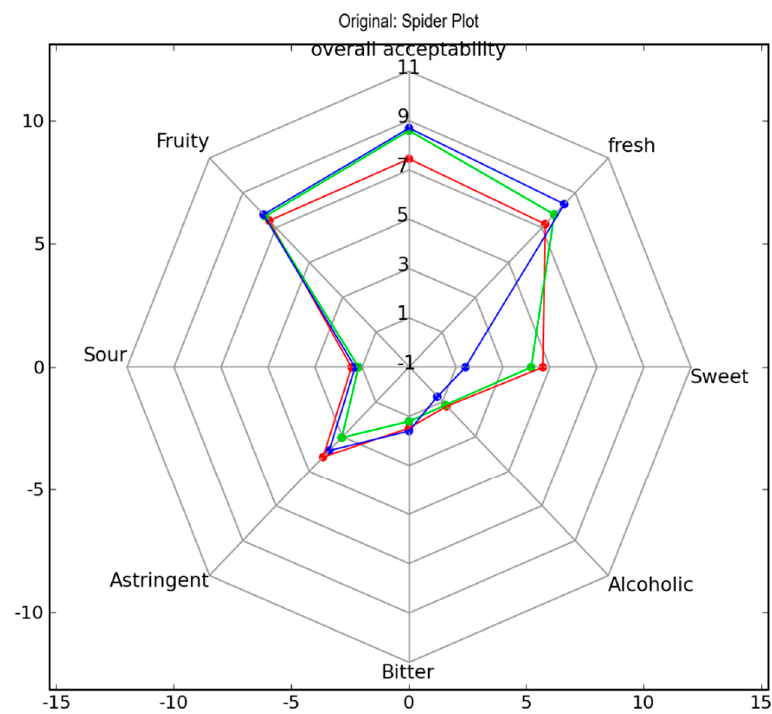
Figure 2. Star chart of the sensory attributes (fruity, sour, astringent, bitter, alcoholic, sweet, fresh, and overall acceptability) evaluated in pomegranate beverages during refrigeration.